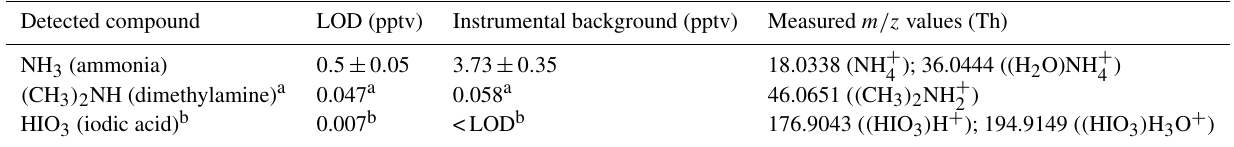
Table 1. Estimated limit of detection (LOD) for some compounds with high proton affinity and for iodic acid measured with the water cluster CI-APi-TOF. The LOD is derived by background measurements at the CLOUD chamber, where LOD = 3 · σ (You et al., 2014). σ is defined as the standard deviation of the background signal. The detection limits are based on a measurement at 278K and 80% RH (1min averaging time). The measured instrumental background mixing ratios (mean values) during this time period are also indicated.